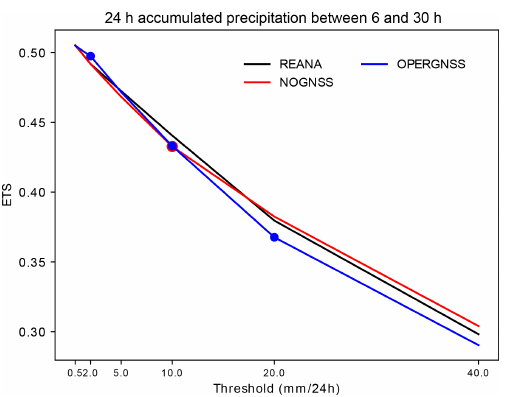
Figure 10. Equitable threat score of 24h accumulated precipitation from the 30 to 54h forecast range of the long forecast initialized at 00:00UTC each day of the period from 5 September to 5 Novem- ber 2012 computed over the AROME-WMED domain with rain gauges of the HyMeX database (version 4). Dots indicate that the difference between the curves is statistically significant.